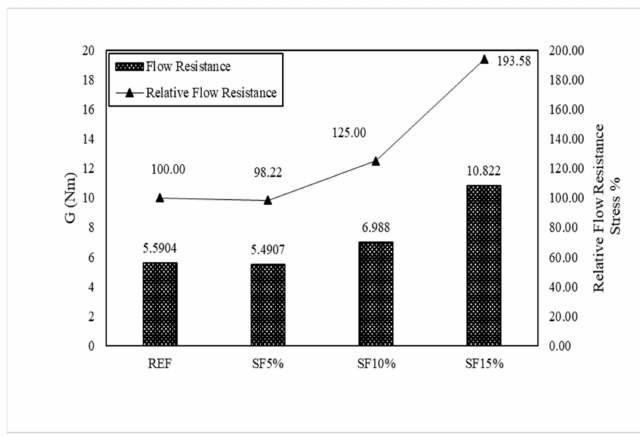
Figure 19. Flow resistance (G) of the mixing ratio (Jeon’s data).